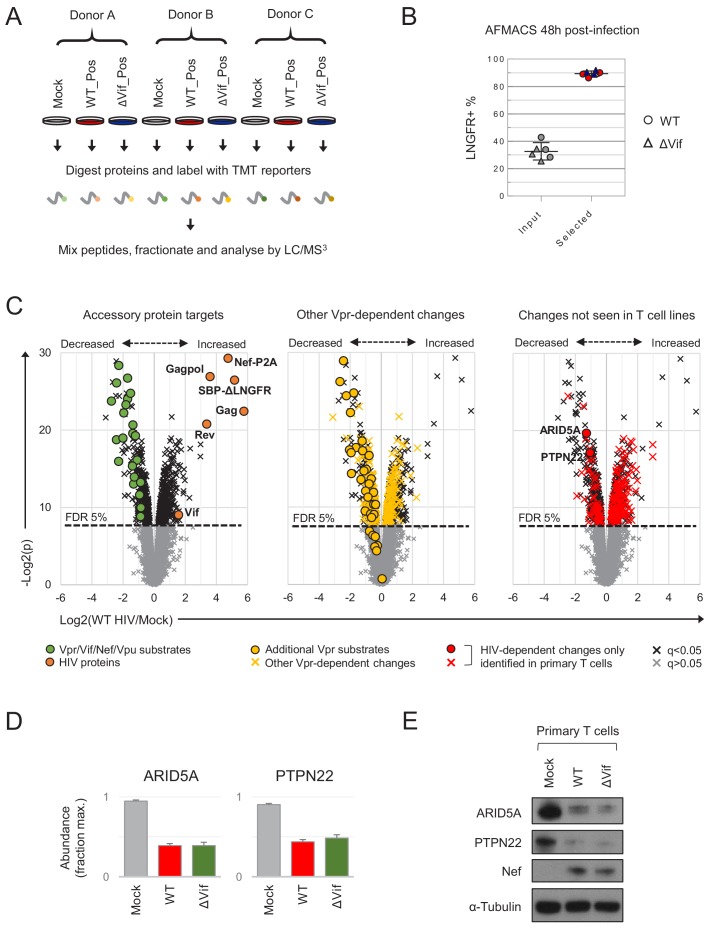
Proteins regulated by HIV in primary T cells.(A) Overview of single time point proteomic experiment. HIV-infected (LNGFR+) primary T cells were isolated using AFMACS 48 hr post-infection with WT (red) or ΔVif (blue) HIV-AFMACS. (B) AFMACS-based enrichment of WT (red circles) and ΔVif (blue triangles) HIV-infected (LNGFR+) cells used for (A), with means and 95% CIs. Corresponding cells pre-selection are included for each donor/virus (WT, grey circles; ΔVif, grey triangles). Cells were stained with anti-LNGFR and anti-CD4 antibodies and analysed by flow cytometry, with representative data in Figure 3—figure supplement 1A. (C) Protein abundances in WT HIV-infected vs mock-infected cells from (A). Volcano plots show statistical significance (y axis) vs fold change (x axis) for 8789 cellular and six viral proteins quantitated in cells from all three donors (no missing values). Proteins with Benjamini-Hochberg FDR-adjusted p values (q values) < 0.05 or > 0.05 are indicated (FDR threshold of 5%). Proteins highlighted in each plot are summarised in the key. Vpr/Vif/Nef/Vpu substrates (green circles) comprise proteins from Figure 2C–D and Figure 2—figure supplement 1B, excluding negative controls (SAMHD1, APOBEC3B, SERINC1, HLA-C) and HLA-A/B alleles (different in each donor) but including SMUG1 (not identified in time course proteomic experiment) (Schröfelbauer et al., 2005) and both quantitated isoforms of PP2R5C (Q13362 and Q13362-4) and ZGPAT (Q8N5A5 and Q8N5A5-2). Additional Vpr substrates (gold circles) and Vpr-dependent changes (gold crosses) comprise recently described direct and indirect Vpr targets (Greenwood et al., 2019). HIV-dependent changes only identified in primary T cells (red circles and crosses) comprise proteins with q < 0.05 either not identified or not concordantly regulated by HIV in CEM-T4s (Greenwood et al., 2016) (and exclude known accessory protein-dependent changes). Further details on comparator datasets used in this figure are provided in the Materials and methods. (D–E) Abundances of ARID5A and PTPN22 in mock-infected (grey), WT HIV-infected (red) and ΔVif HIV-infected (green) primary T cells from (A). Mean abundances (fraction of maximum) with 95% CIs are shown (D). As well as proteomic analysis, cells from donor A were lysed in 2% SDS and analysed by immunoblot with anti-ARID5A, anti-PTPN22, anti-Nef and anti-α-tubulin antibodies (E). Same lysates as Figure 5D.
10.7554/eLife.41431.011Figure 3—source data 1.Proteins regulated by HIV and/or control lentivectors.Interactive filter table summarising proteomic data for proteins significantly regulated by HIV (‘q < 0.05_WT HIV (n = 650)’ worksheet) and/or control lentivectors (‘q < 0.05_ctrl lentivectors (n = 37)’ worksheet). Log2(ratio)s and q values (Benjamini-Hochberg FDR-adjusted) from the single time point proteomic experiment (Figure 3A) and SBP-ΔLNGFR control proteomic experiment (Figure 3—figure supplement 4A) are included, with q values < 0.05 highlighted in red. Where known, mechanisms underlying HIV-dependent proteins changes are shown, with proteins colour-coded to match the volcano plots in Figure 3C and pie chart in Figure 3—figure supplement 3B (green, controls/known accessory protein targets; gold, novel Vpr targets/Vpr-dependent changes [Greenwood et al., 2019]); red, novel/uncharacterised changes). NaN, protein not detected.